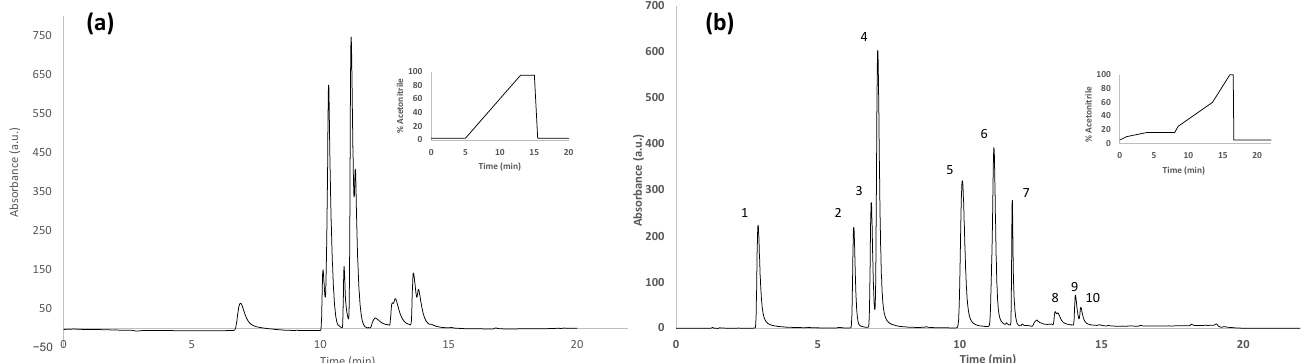
Figure 4. HPLC-UV chromatograms (at 280 nm) for a mixture of 10 selected polyphenols (at 25 mg L − 1 - each) obtained under ( a ) a universal gradient elution and ( b ) the proposed optimized gradient elution. Gradient programs are also depicted in the figures. Peak identification: 1, gallic acid; 2, p -hydroxybenzoic acid; 3, vanillic acid; 4, caffeic acid; 5, p -coumaric acid; 6, ferulic acid; 7, hesperidin; 8, luteolin; 9, apigenin; 10, kaempferol.